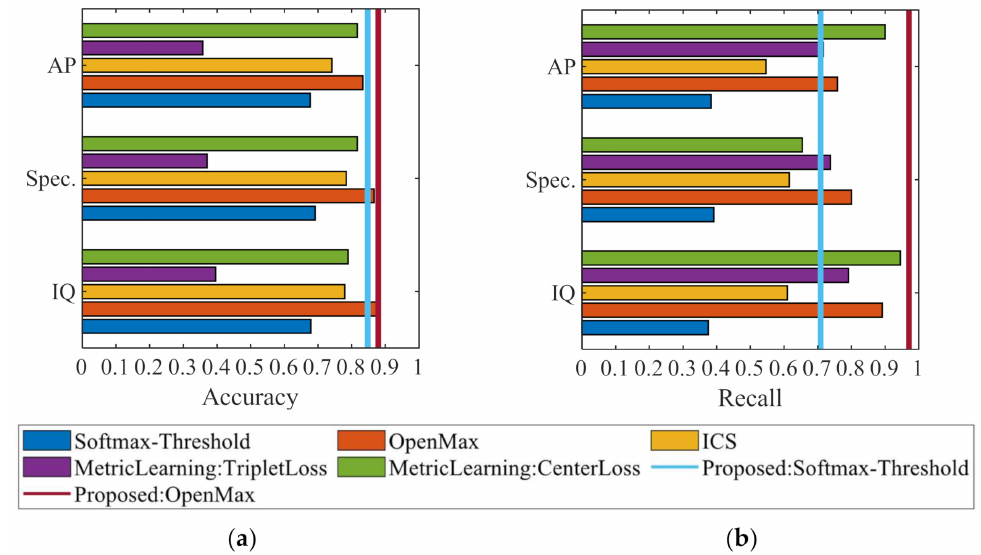
Figure 10. Comparisons with other methods in open-set SEI. ( a ) Accuracy of all communication devices. ( b ) Recall of UUC